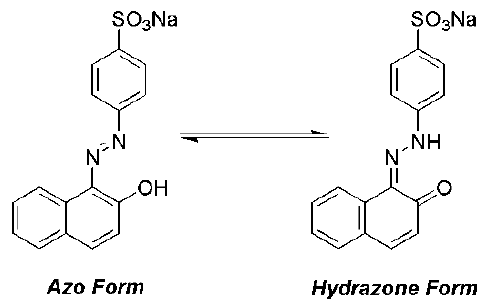
Scheme 1. The tautomeric forms of Orange II.